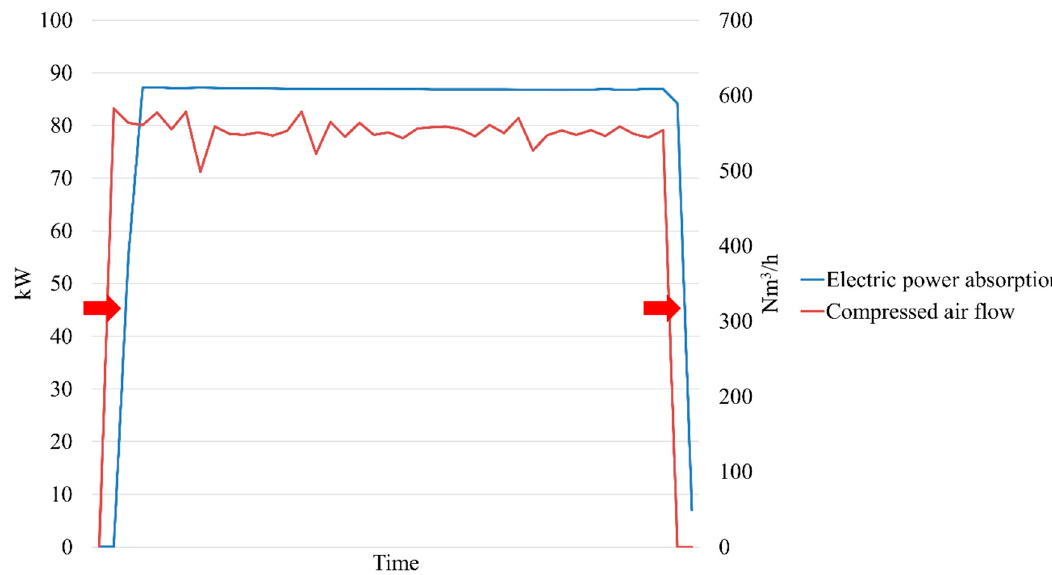
Figure 5. Electric power absorption and compressed air flow rate over time. The graph shows a 15 minutes delay between electric power absorption and compressed air production (data at a 15 minute frequency).